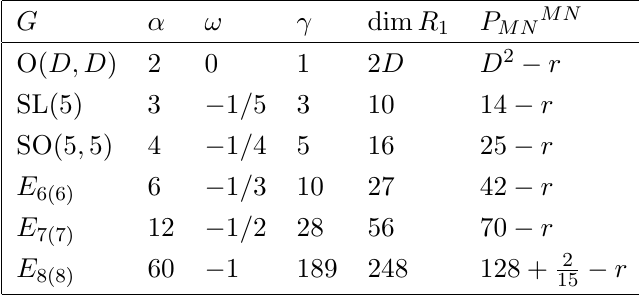
, when r = 2 . 8(8) 15 the trace of the pro- 8(8) we 8(8)